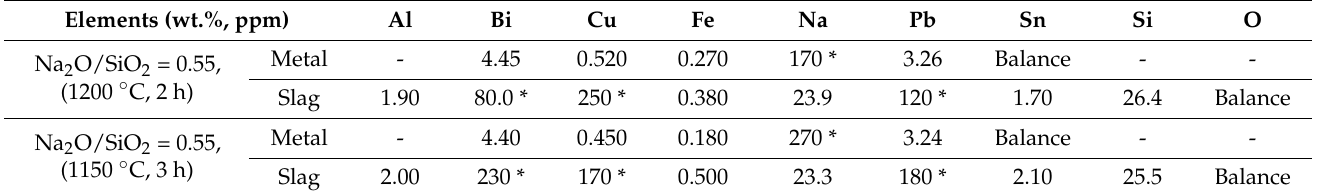
Table 3. The chemical composition of produced metal and slag (*: ppm unit).